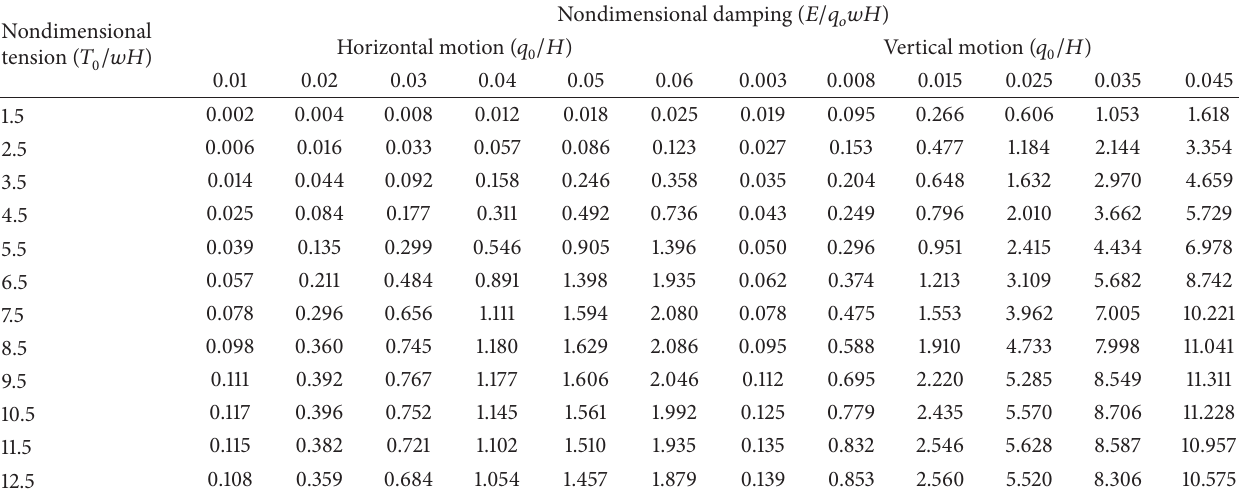
Table 3: Mooring line damping estimation under different excitation